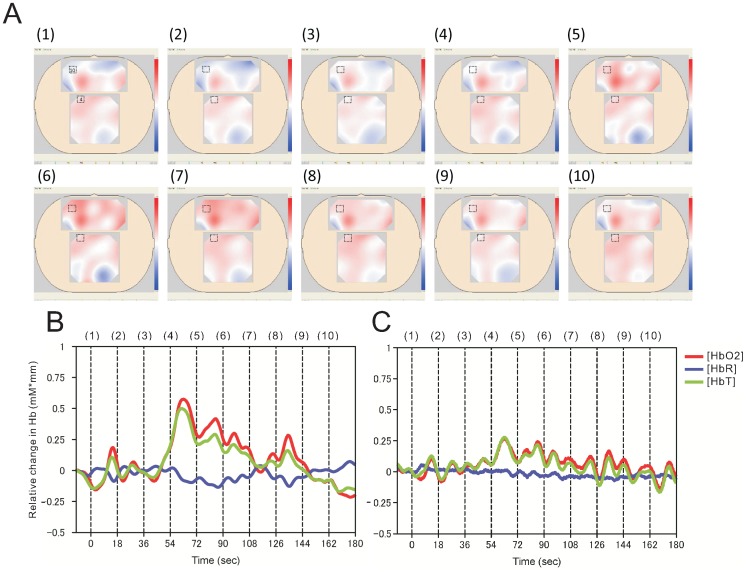
Dynamic brain cortex responses and imaging after pain stimulation.(A) Ten sequential NIRS images, obtained every 18 seconds, and numbered from 1 to 10. Red indicates that [HbO2] was above the level in the resting state and blue indicates that [HbO2] was lower than the resting level. Changes in [HbT] and [HbR] are not included in the present NIRS images. The small rectangles in the frontal and parietal areas correspond to the location of channel 10 and 4, respectively. (B) The dynamic trace recorded from channel 10 in the frontal area. The numbers 1 to 10 along the upper Y axis correspond to the numbered images in A. (C) The dynamic trace recorded from channel 4 in the parietal area. The numbers 1 to 10 along the upper Y axis correspond to the numbered images in A.